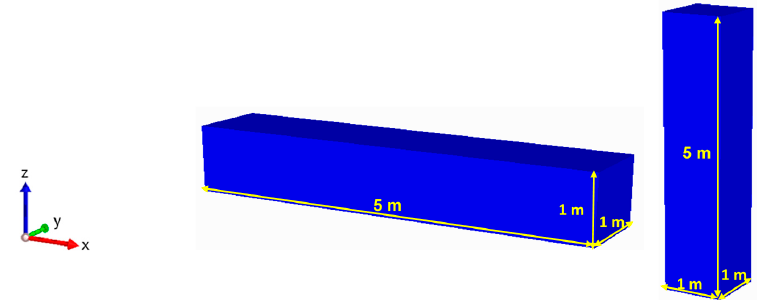
Figure 3. Three-dimensional views of the horizontal (left) and vertical (right) elemental reservoir simulation models. In both models, each grid block has dimensions of 1 cm in all directions leading to a total of five million grid blocks for each model. The boundary conditions are described in the text. Table 1. Reservoir properties used in thermal reservoir simulation model.